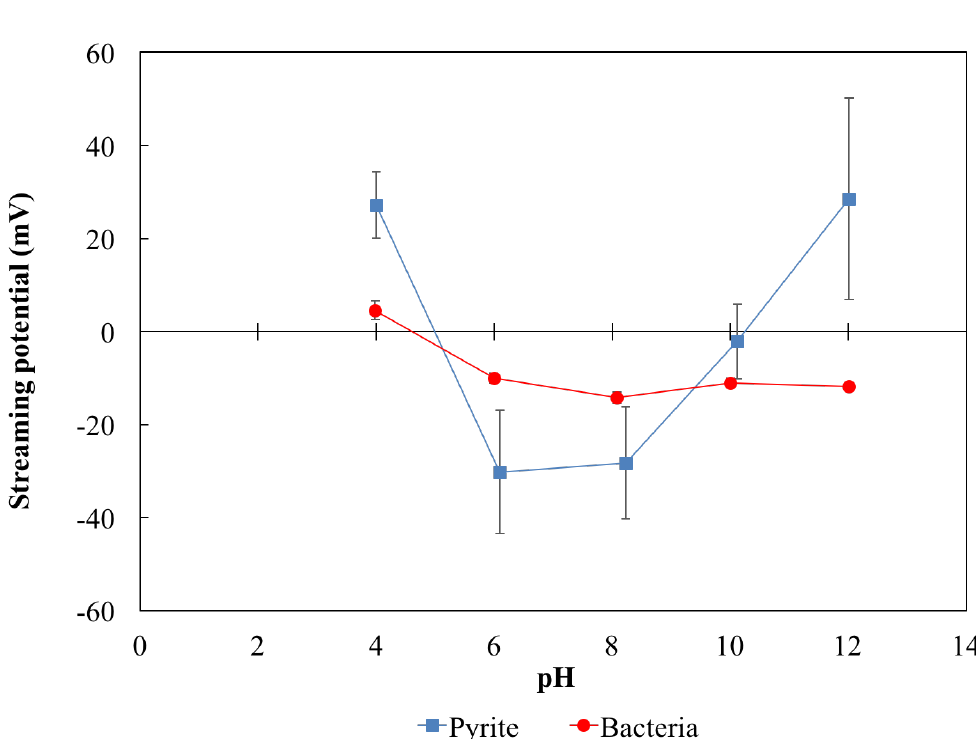
Figure 3. Streaming potential of A. ferrooxidans and pyrite in saline water (35g/L NaCl or